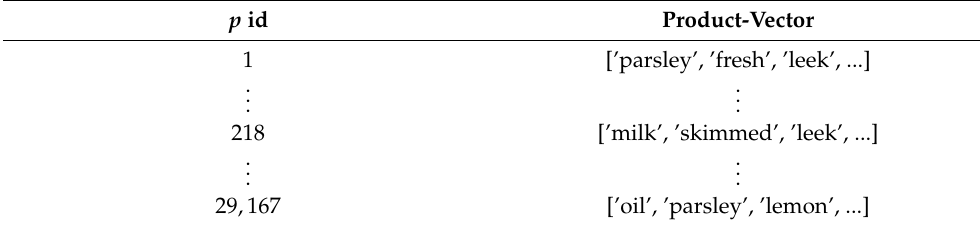
Table 5. Examples of product _ words for every p .